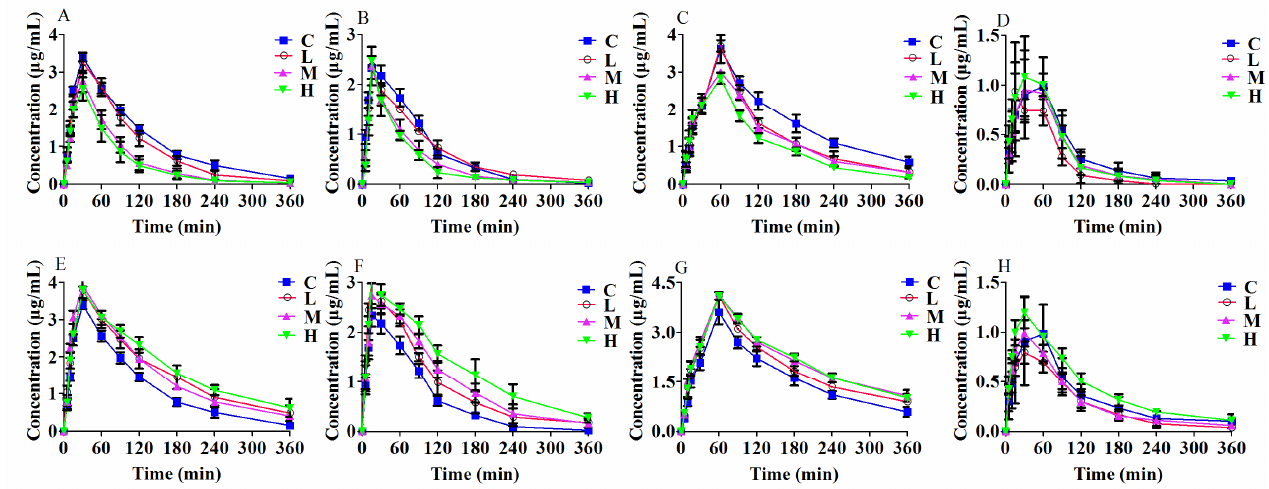
Figure 7. Plasma concentration-time curves of midazolam ( A ), phenacetin ( B ), chlorzoxazone ( C ), omeprazole ( D ) after i.g. administrated with curcumin (C: control, L: 10, M: 40, H: 80 mg/kg/d), and midazolam ( E ), phenacetin ( F ), chlorzoxazone ( G ), omeprazole ( H ) after i.g. administrated with germacrone (C: control, L: 1, M: 4, H: 8 mg/kg/d) in rats (mean ± SD, n = 6).